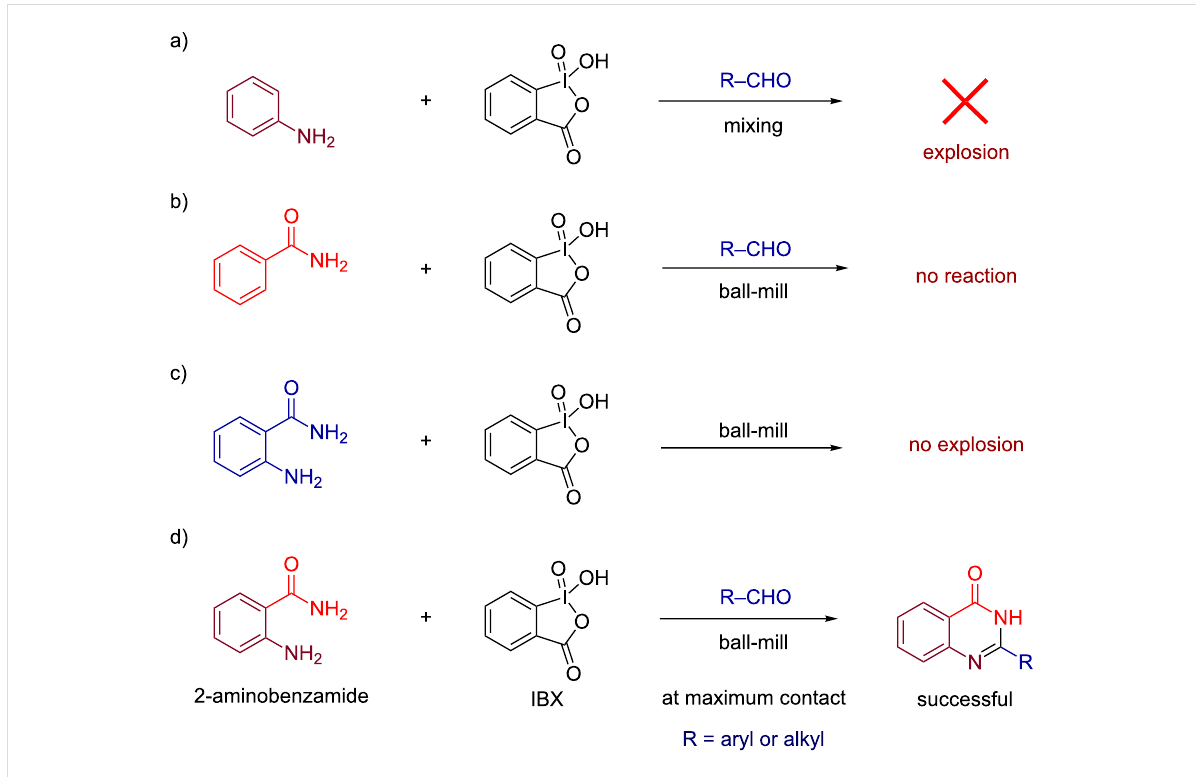
Figure 1: a) Explosion was observed when an arylamine was mixed with aldehydes in the presence of IBX. b) Benzamide was found to be unreac- tive with IBX. c) Treatment of 2-aminobenzamide with IBX did not lead to any explosion. d) Reaction of 2-aminobenzamide and aldehydes in the pres- ence of IBX as oxidant afforded quinazolin-4(3 H )-ones at maximum interaction of the reactants, i.e., under ball-milling